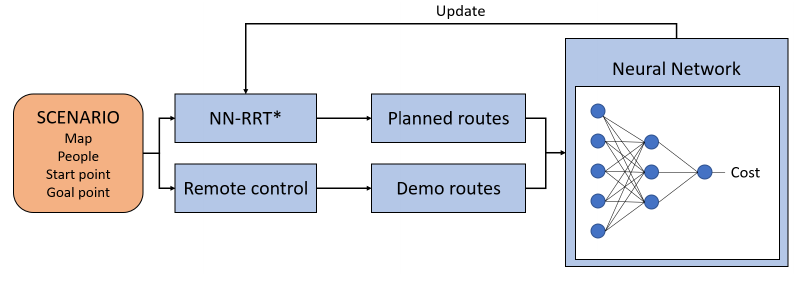
Figure 12. Overview of the NRTIRL [117].